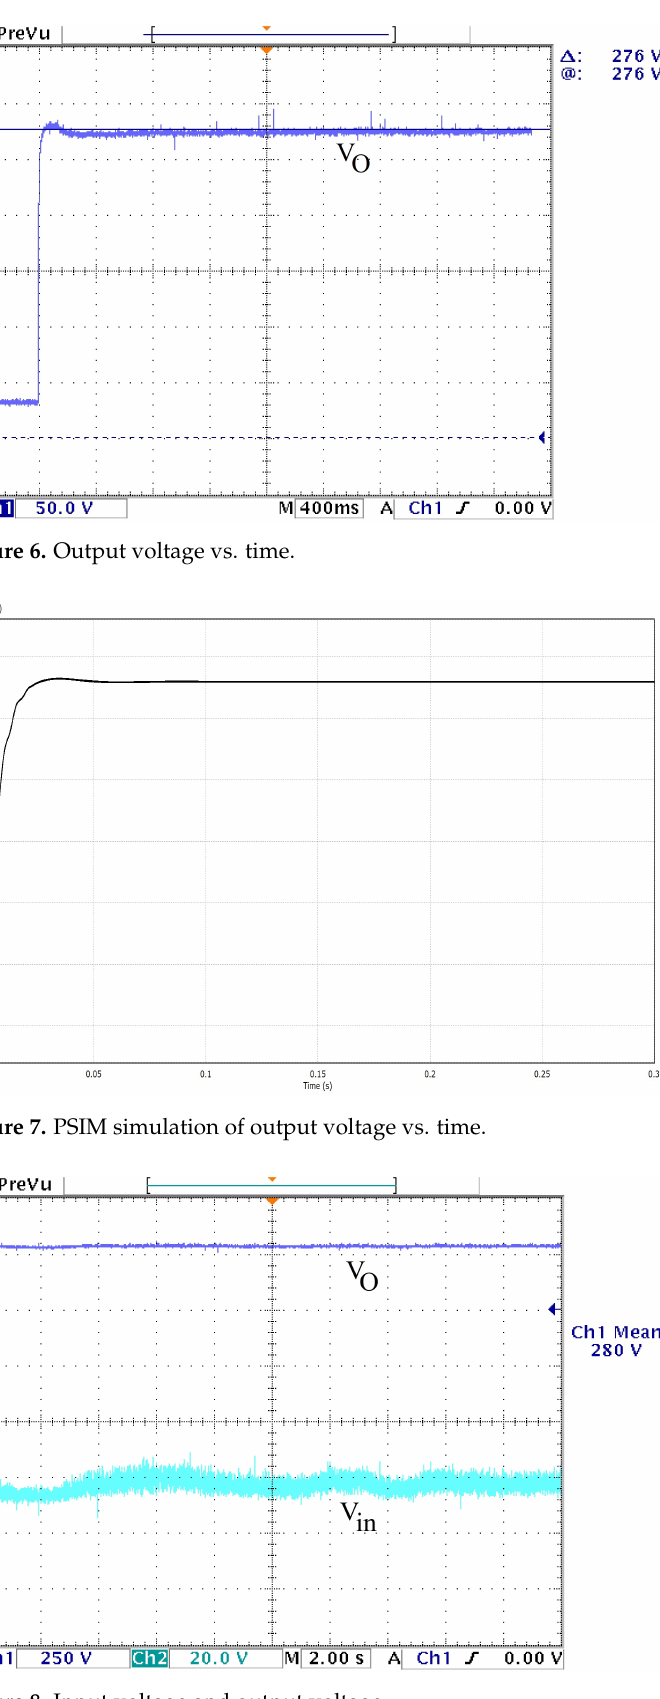
Figure 8. Input voltage and output